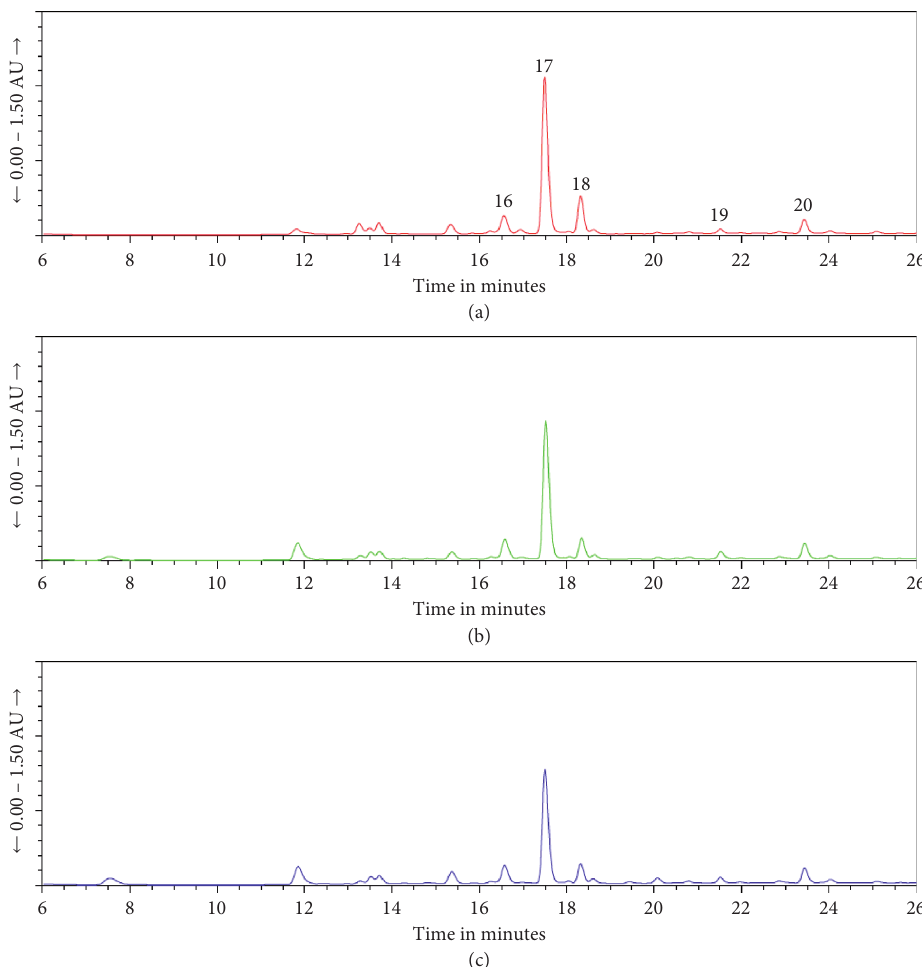
Figure 5: Changes in HPLC patterns of brown teff phenolic compounds (bound fraction) due to mushroom mycelium-mediated solid-state fermentation. (a) Matched control (unfermented); (b) G . lucidum (KACC 42231); (c) P . ostreatus (KACC